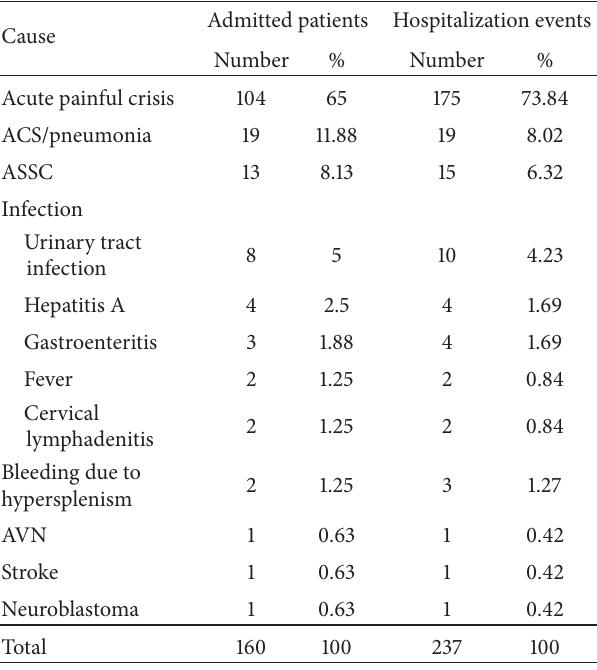
Table 2: Causes of hospital